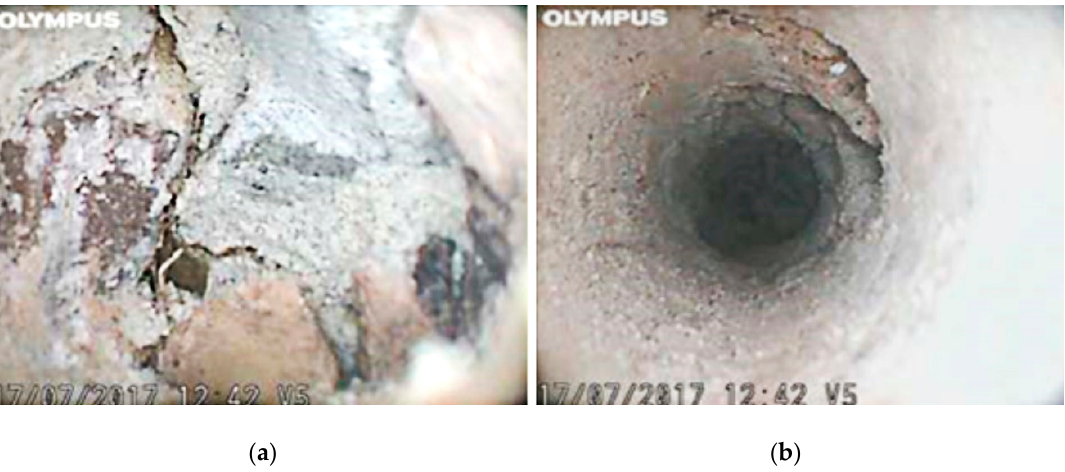
Figure 10. Videoendoscopy V5-from ceiling: ( a ) Image at 11 cm from the beginning of the hole reveals filling in unbound material; ( b ) Image at 5 cm from the beginning of the hole presents brick and mortar elements.